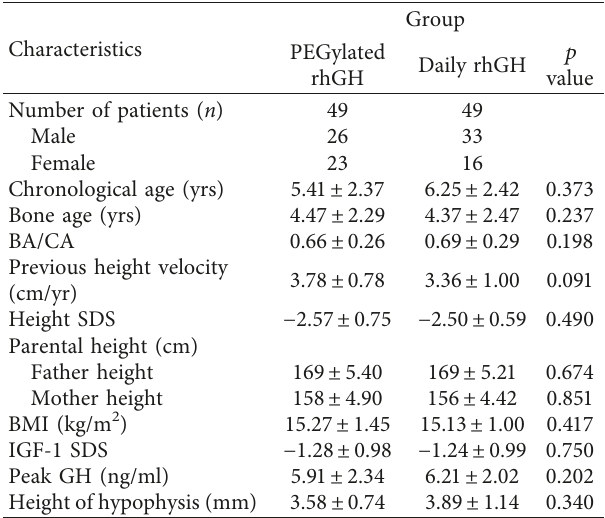
Table 1: Demographic and baseline characteristics.